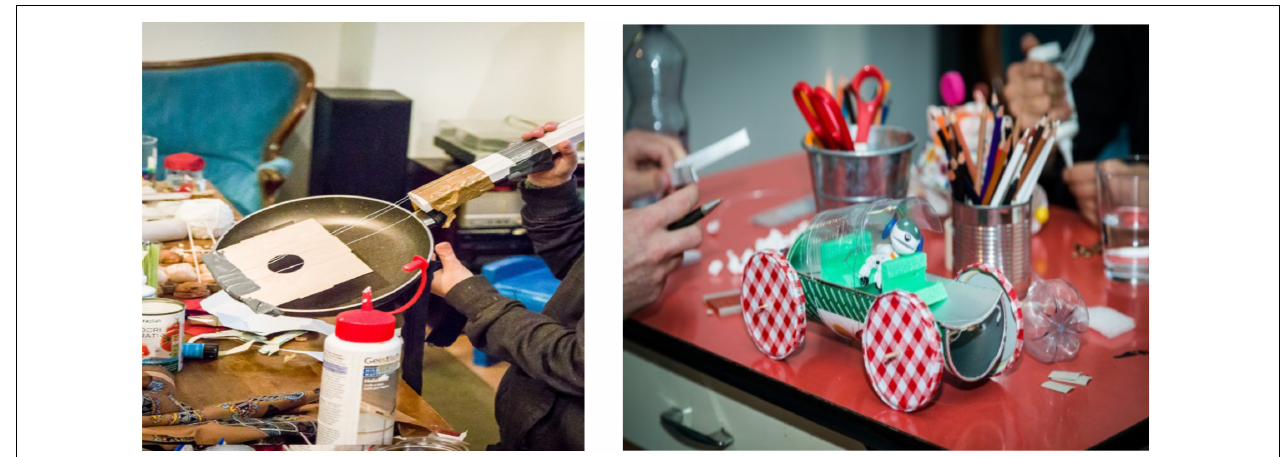
FIGURE 1 | Two examples of the products created in workshops 1 and 2.